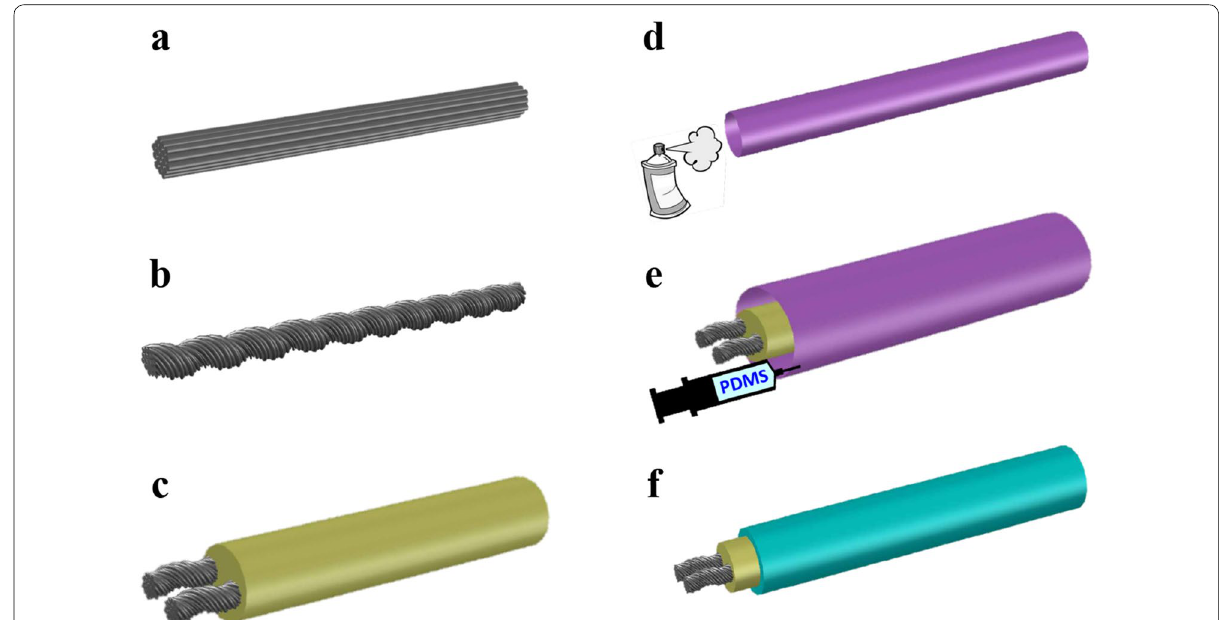
Fig. 2 Fabrication sequences of the proposed flexible cable-shaped supercapacitor: a deposition of GFs on the surface of the CF bundles, b 20 times twisted CF bundles, c deposition of gel electrolyte, d spraying of release agent, e injection of PDMS, and f removal of the shrinkable tube